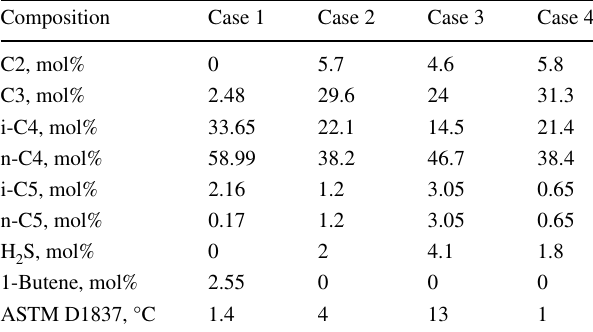
Table 3 Collected data of LPG weathering experiment